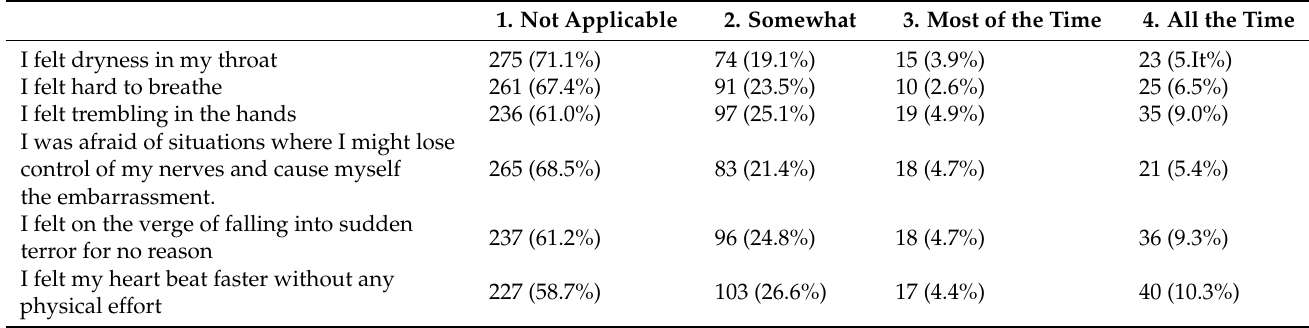
Table 4. Stress and anxiety indicators of the Saudi day traders.